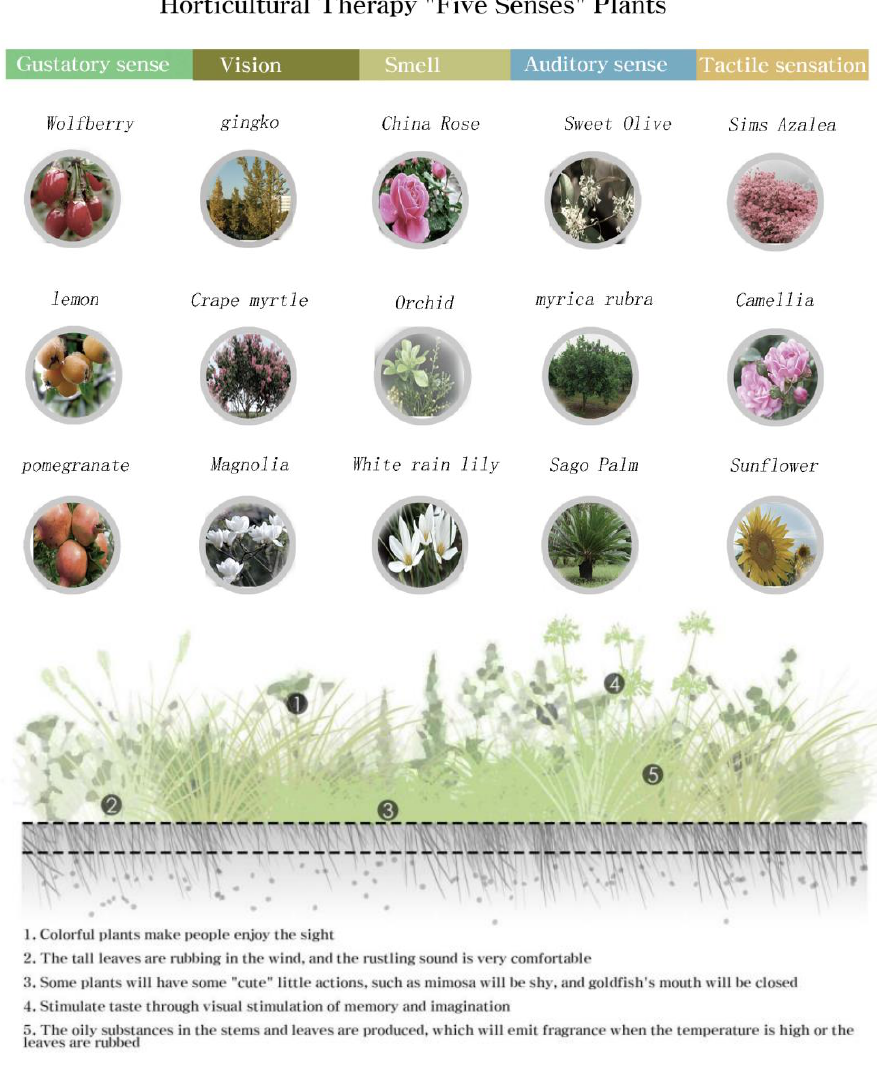
As shown in Table 2 below.The respondent population was divided into three parts: working professionals, students studying landscape architecture, and non-landscape ar- chitecture professionals. As far as possible, a certain sample size was ensured for different groups of people to better analyze and compare the views of different respondents and to ensure more objective and accurate results.